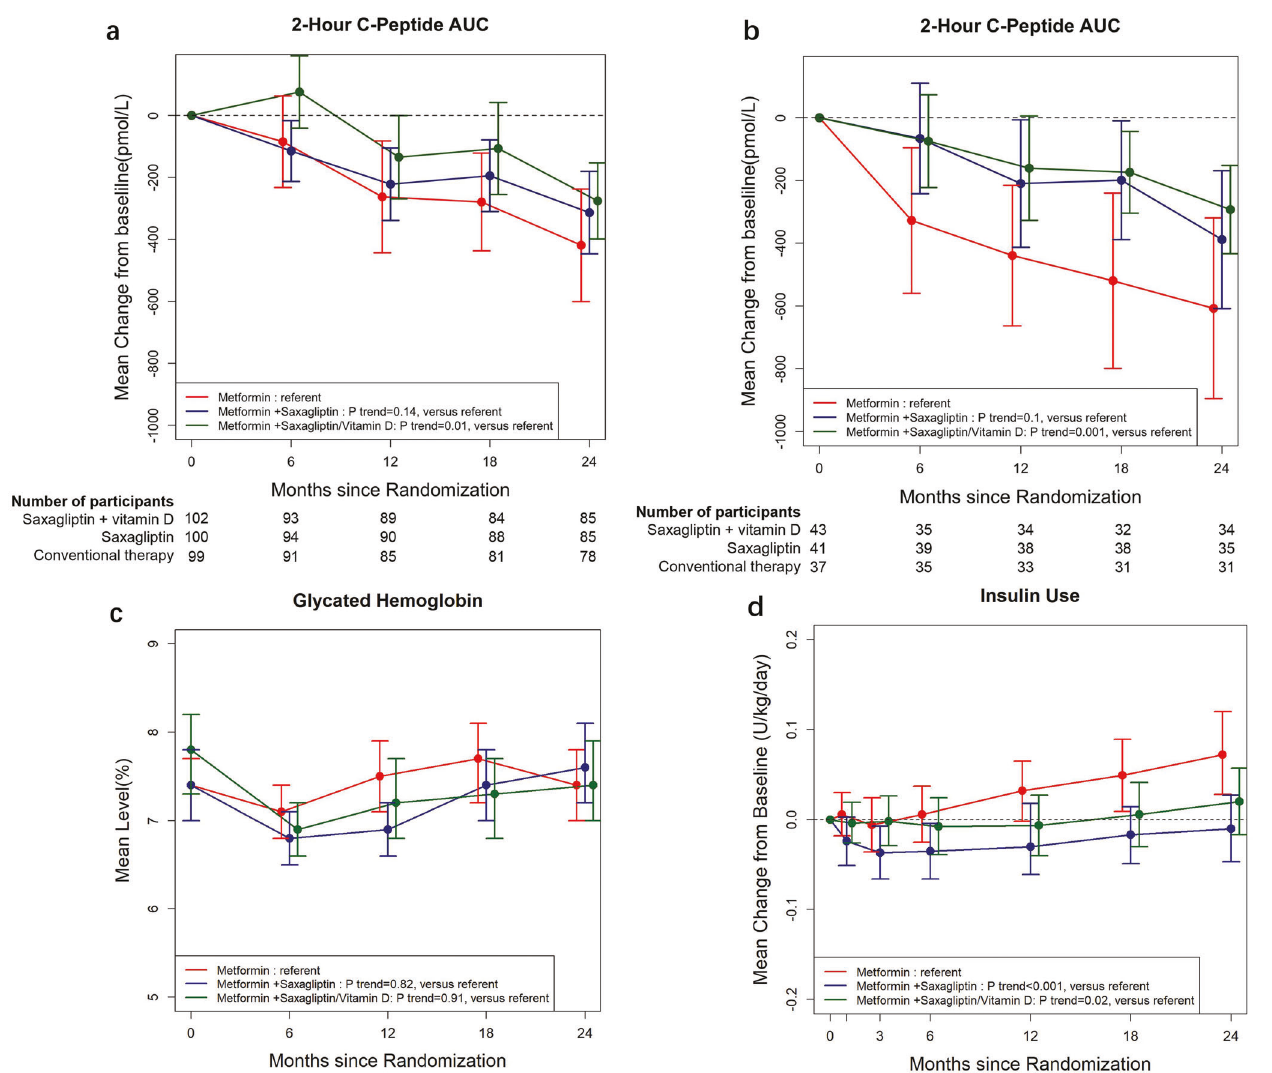
Fig. 1 Effects of Saxagliptin and Saxagliptin plus Vitamin D on Secondary Endpoints. a Mean change from baseline through 24 months in the mixed-meal-stimulated C-peptide AUC among all participants in the saxagliptin, saxagliptin plus vitamin D and conventional therapy groups. b Mean change from baseline through 24 months in the mixed-meal-stimulated C-peptide AUC among participants with a high baseline GADA level of >577 U/mL in the saxagliptin, saxagliptin plus vitamin D and conventional therapy groups. c Mean glycated haemoglobin concentrations from baseline through 24 months. d Mean change from baseline through 24 months in total daily insulin use. Error bars indicate 95% con fi dence intervals; the mean values and their corresponding 95% con fi dence intervals are according to observed data. P for trend is obtained using mixed models for repeated measures. AUC area under the curve; GADA glutamic acid decarboxylase